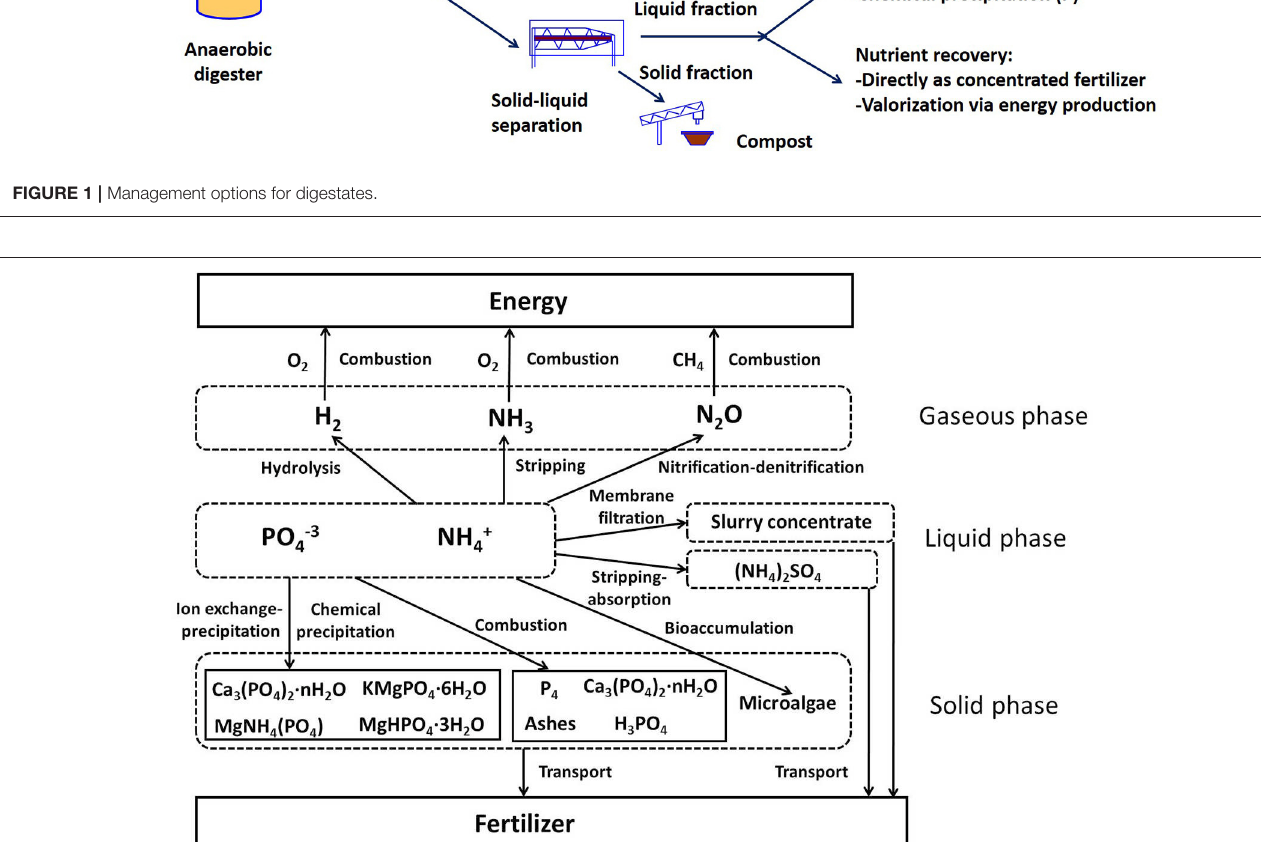
FIGURE 2 | Alternatives for minimizing transport costs during the recovery and/or valorization of nutrients contained in the liquid fraction separated from